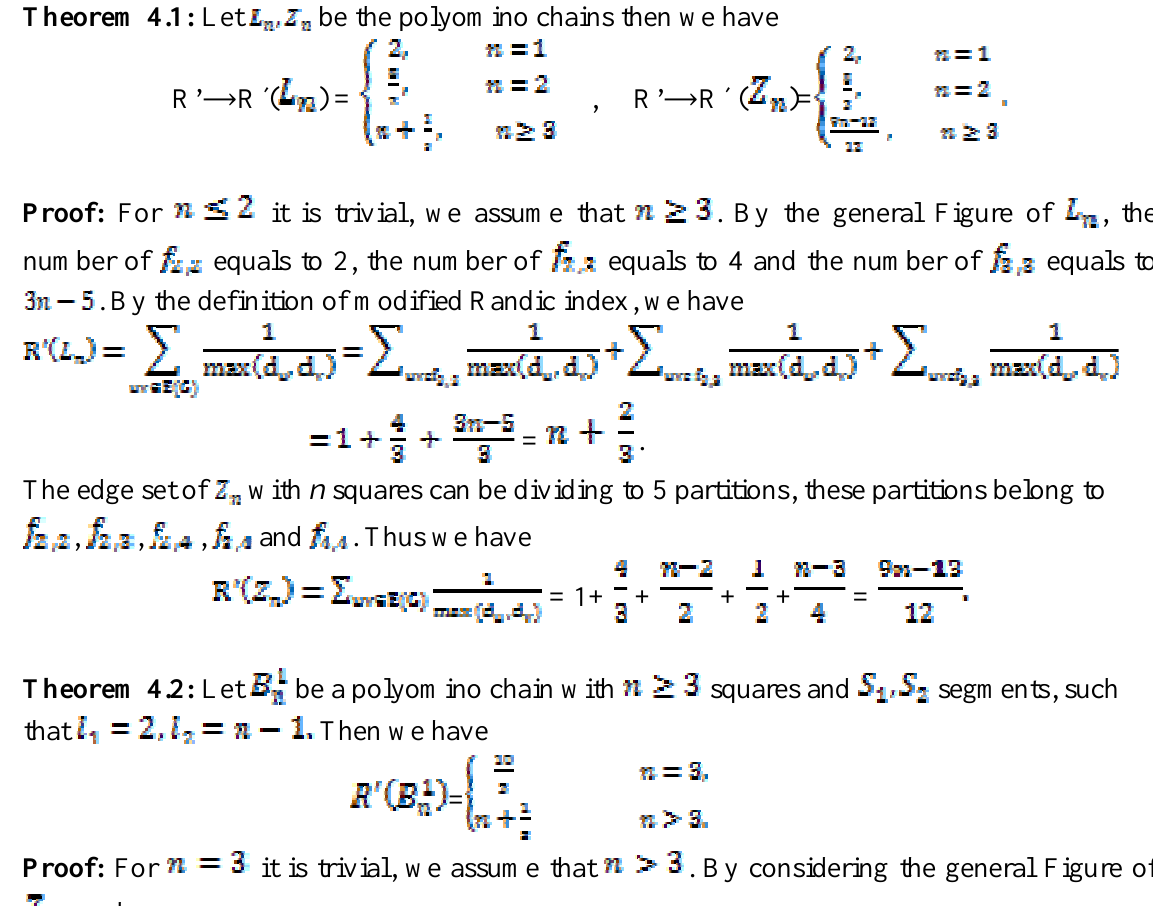
Fig. 8 . The Zig-Zag